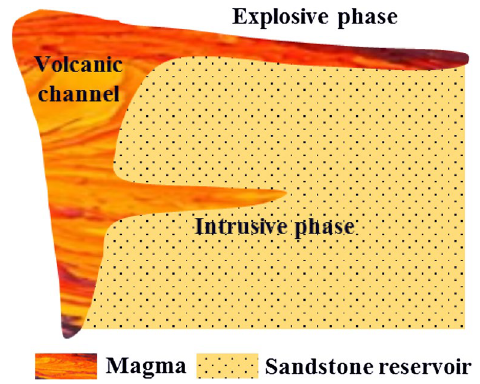
Fig. 1 Igneous rock development